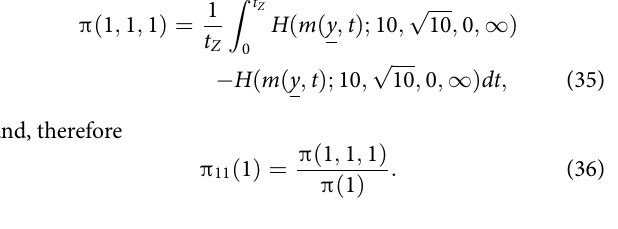
TABLE 2 | Definition of condition states.